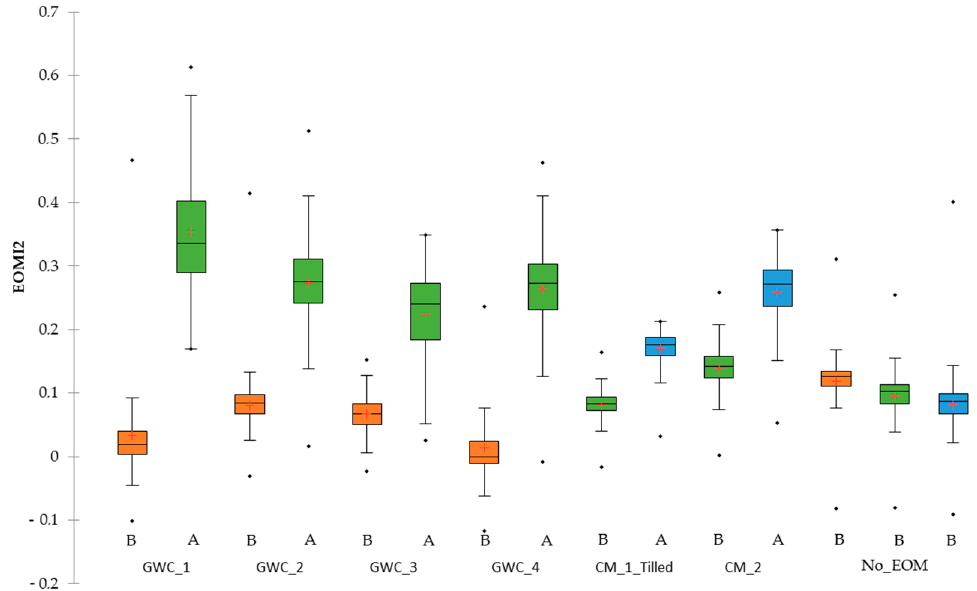
Figure 5. Boxplots of EOMI2 pixels values before ( B ) and after ( A ) EOM amendment for each studied field. Sentinel-2 acquisition dates are 25 July 2018 (orange), 02 August 2018 (green) and 04 August 2018 (blue).